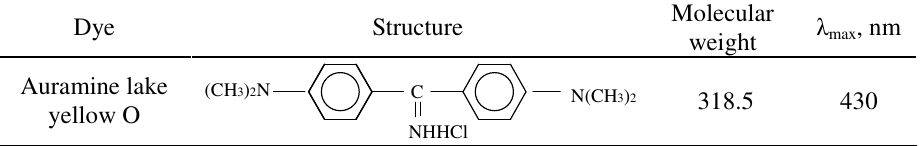
Table 2. Chemical structure and molecular weight of dyes used in experiment Dye Structure